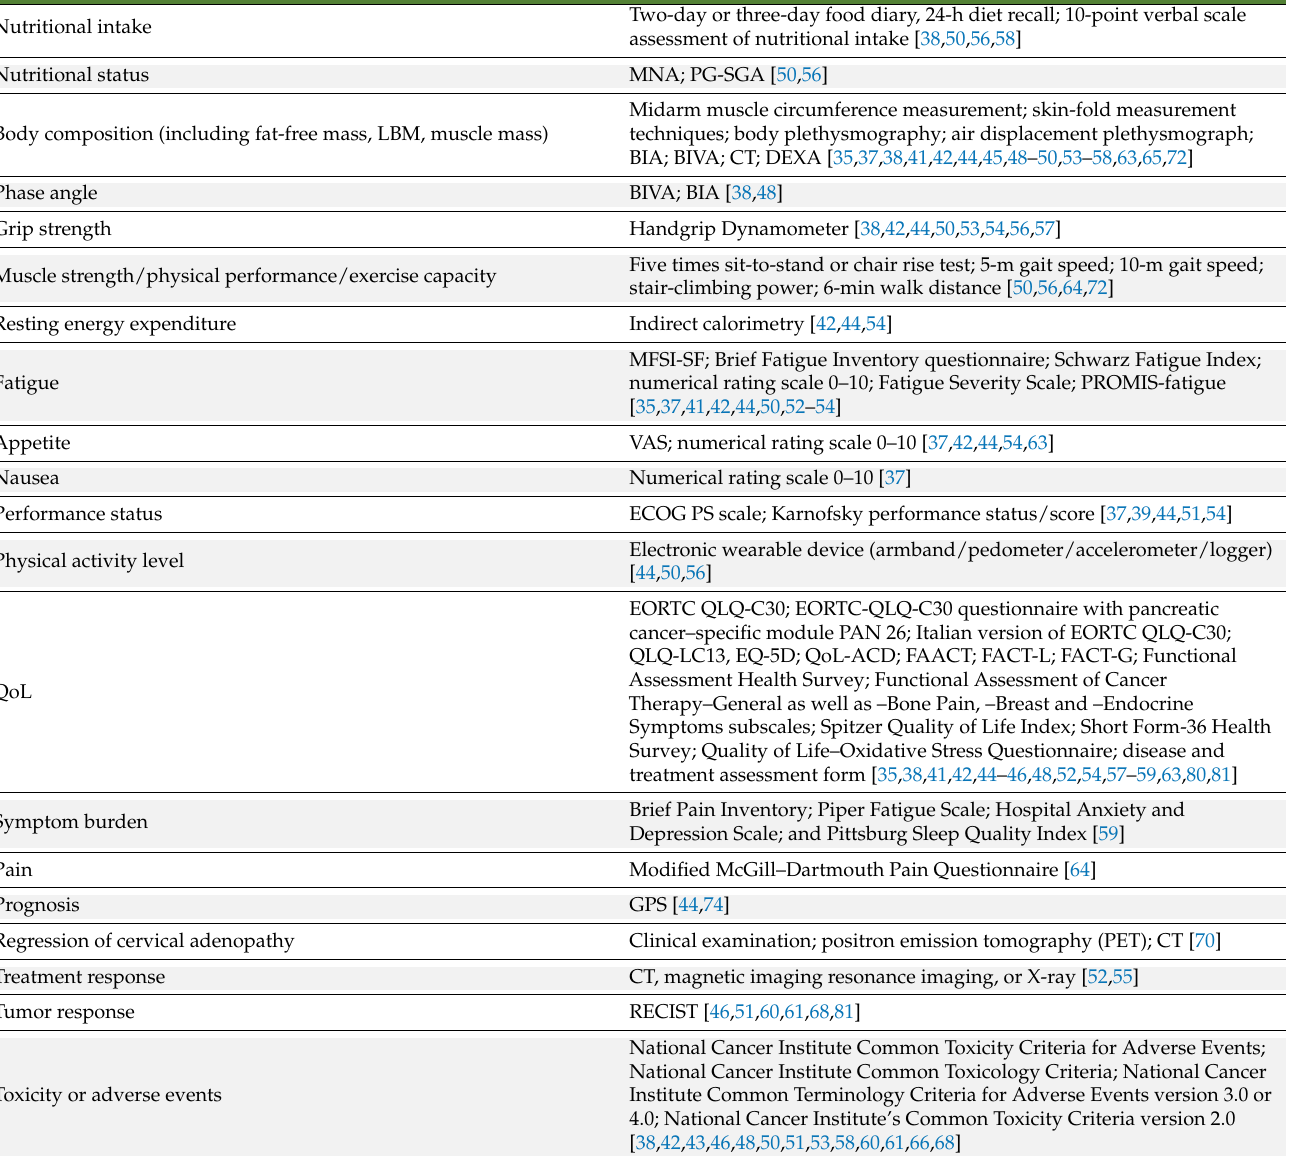
Table 5. Outcome measures and corresponding tools used in included